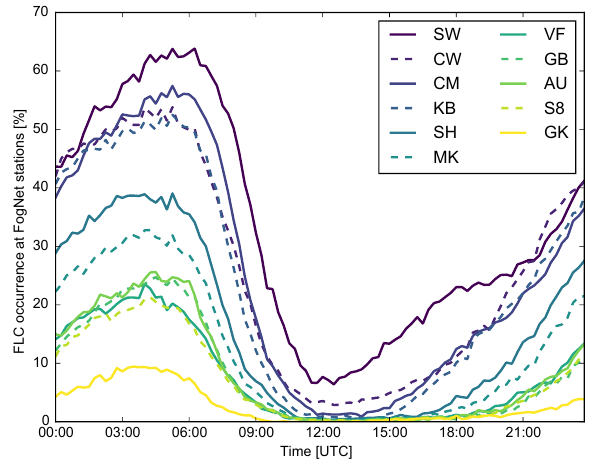
Figure 5. Average diurnal cycle of the FLC occurrence at FogNet stations. Lines are colored by the longitudinal rank of each specific station, with coastal stations in dark colors and stations further in- land in brighter colors. Every other line is dashed with the only purpose of helping their visual